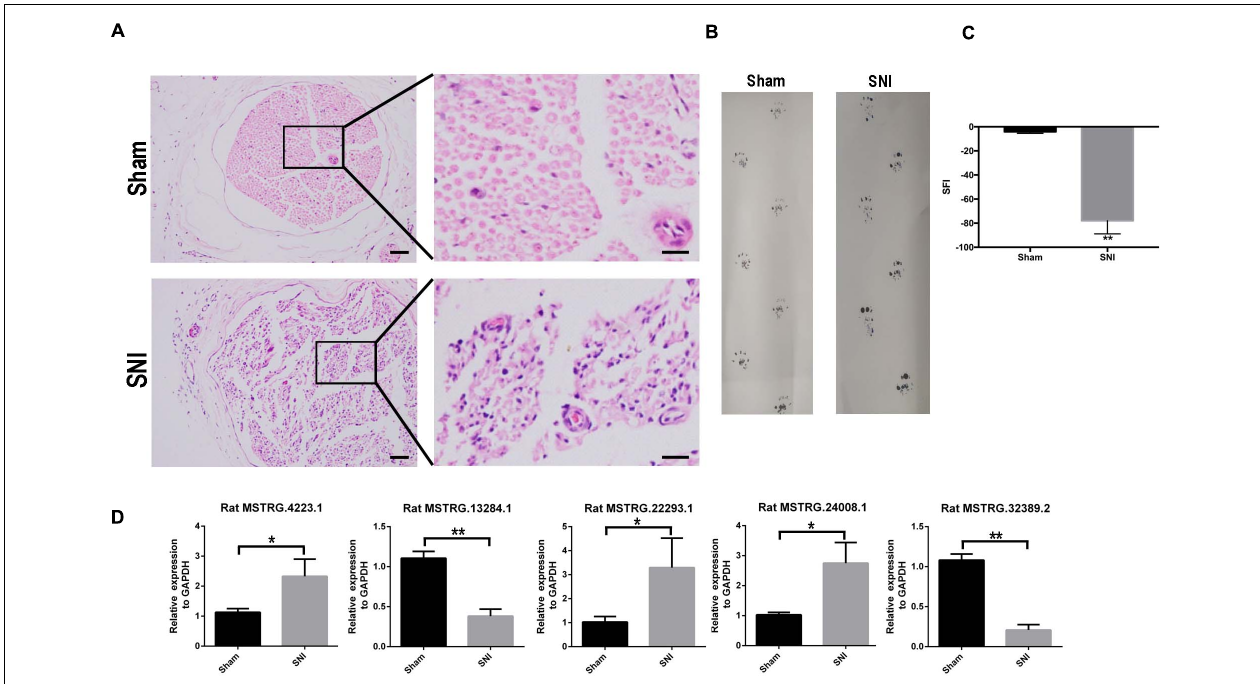
FIGURE 1 | lncRNA expression increased after sciatic nerve injury. (A) Sciatic nerves, with or without injury, as analyzed using H&E staining. (B) Rat footprint function assessment ( n = 6). (C) The SFI of (B) were measured using statistical analysis. Student’s t -test, ** P < 0.01. Data are presented as the means ± SD. (D) qRT-PCR analysis showing the expression levels of injury-related lncRNAs after sciatic nerve injury that increased or decreased. Student’s t -test, * P < 0.05, ** P < 0.01. Data are presented as the means ± SD. Scale bar: 50 and 10 µ m in (A) . Data are representative of at least three independent experiments.